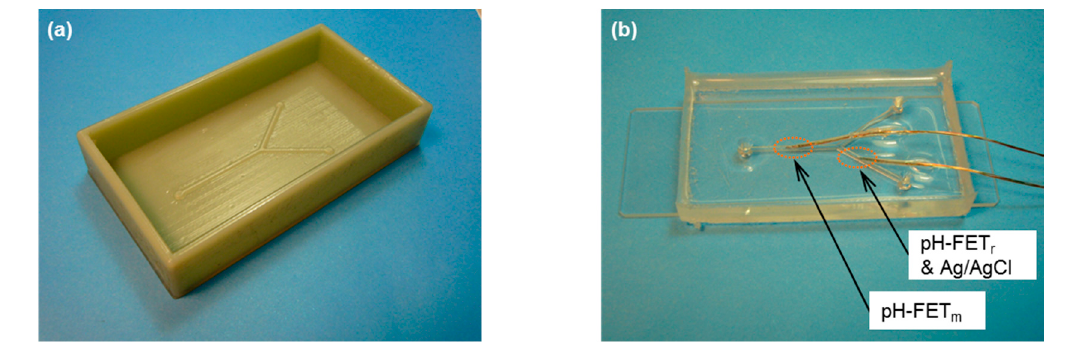
Figure 4. ( a ) A mold fabricated using a rapid prototyping system. External form: 36 × 63 × 12 mm. ( b ) Overview of a microfluidic device with pH-FET sensors. External form of the main body: 32 × 76 × 7 mm.